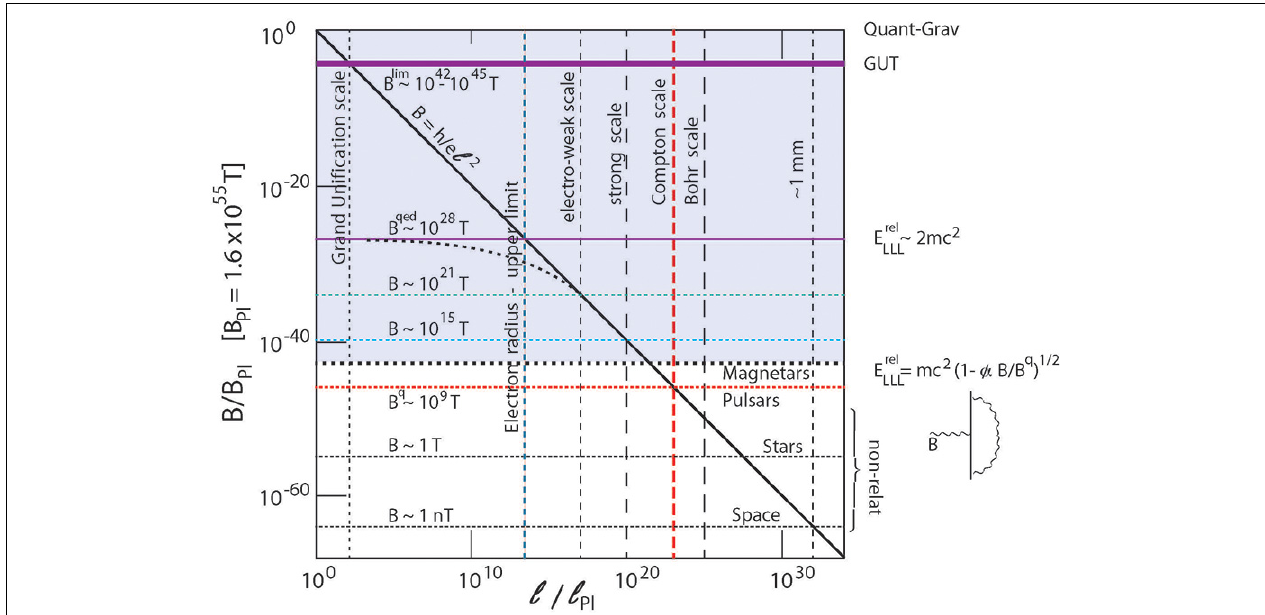
FIGURE 1 | Log-Log plot scaling of the maximum possible magnetic field strength, B c , normalized to the (fictitious) Planck-magnetic field, B Pl , as function of fundamental length scales based on Equation (3). Length scales (cid:5) on the abscissa are normalized to the Planck length (cid:5) Pl . The dotted red cross indicates the crossing point of the Compton length with the Aharonov-Bohm critical magnetic field line at the so-called quantum limit field B q ≈ 10 9 T, the critical field of magnetized neutron stars (pulsars) in agreement with observation of the strongest cyclotron lines. Horizontal lines indicate the relation between other length scales and critical magnetic fields under the assumption of validity of the Aharonov-Bohm scaling. Space magnetic fields correspond to scales